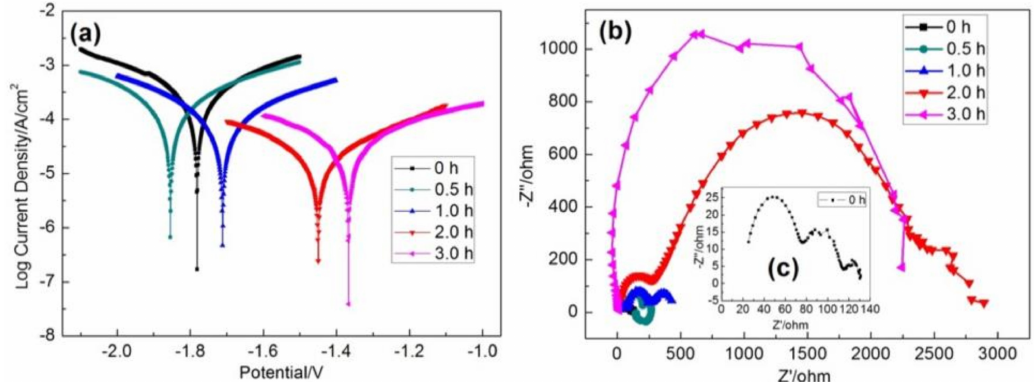
Figure 6. ( a ) Polarization curves and ( b , c ) Nyquist plots of untreated samples and samples HT0.5, HT1, HT2 and HT3 prepared by hydrothermal treatment in 0.5 M NaHCO 3 at 200 ◦ C for 0.5, 1, 2 and 3 h